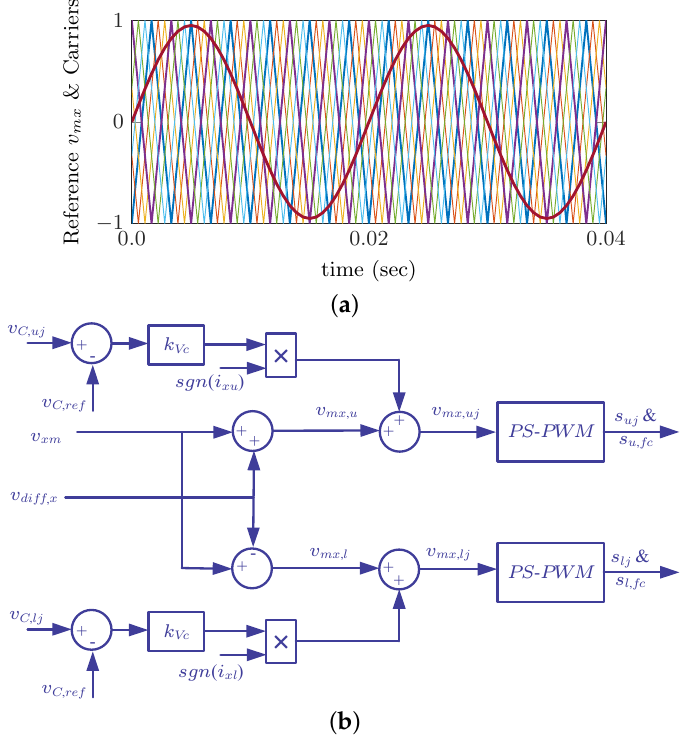
Figure 4. Modulation of the proposed hybrid modular multilevel converter (HMMC): ( a ) phase-shifted (PS)-PWM carriers and reference signal ( v mx , uj ) ; ( b ) Generation of the references and switching